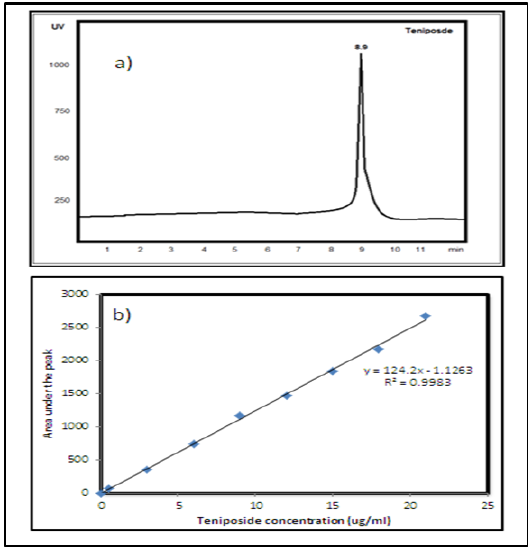
Figure(1) HPLC a) The chromatogram of teniposide b) Teniposide calibration curve in